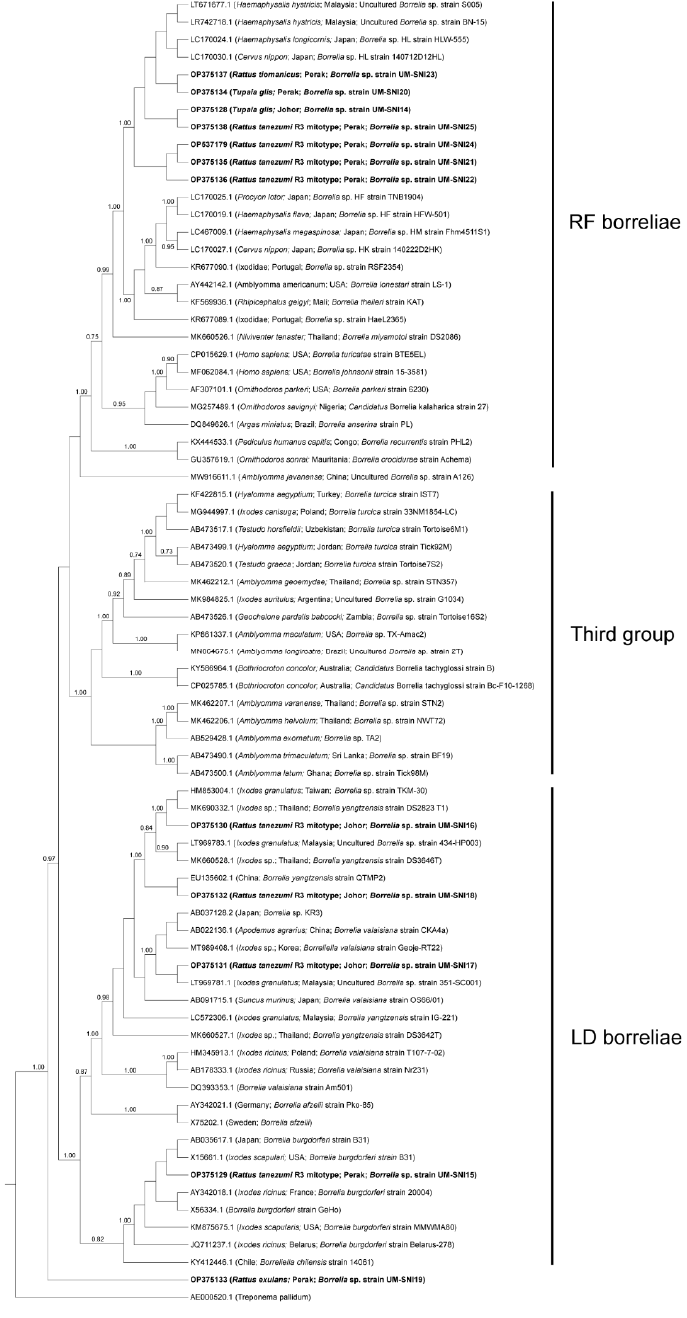
Figure 2. Bayesian inference phylogenetic tree of Borrelia spp. based on the partial sequences (270–300 bp) of the flaB gene. Posterior probability (PP) is shown on the branches. Only PP > 0.7 are shown. Newly generated sequences are in bold text, with their accession numbers followed by the animal host species, location and strain name in parentheses. The reference sequences are labelled with their accession numbers followed by the host, location and Borrelia spp. strain in parentheses (some only contain partial information). LD = Lyme disease-related, RF = relapsing fever-related. Notably, specimen UM-SNI19 was separately distinct from all other groups, forming a sister clade next to the other LD borreliae members with less than 0.7 PP. BLASTn analysis showed that UM-SNI19 has less than 90% identity to both LD and RF